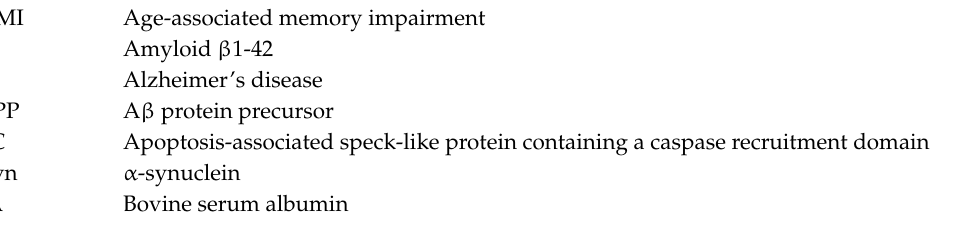
Figure S1: Immunofluorescence of apoptosis-associated speck-like protein containing a caspase recruitment domain (ASC) ASC Speck Detection. Immunofluorescence images of apoptosis-associated speck-like protein containing a caspase recruitment domain (ASC) expression in lipopolysaccharide (LPS)-primed (1g / mL, 4 h) human monocytic cell lines (THP-1) treated with nigericin (Nig, 10 µ M, 1 h) or amyloid β (A β , 10 µ M, 6 h). Scale bar = 50 µ